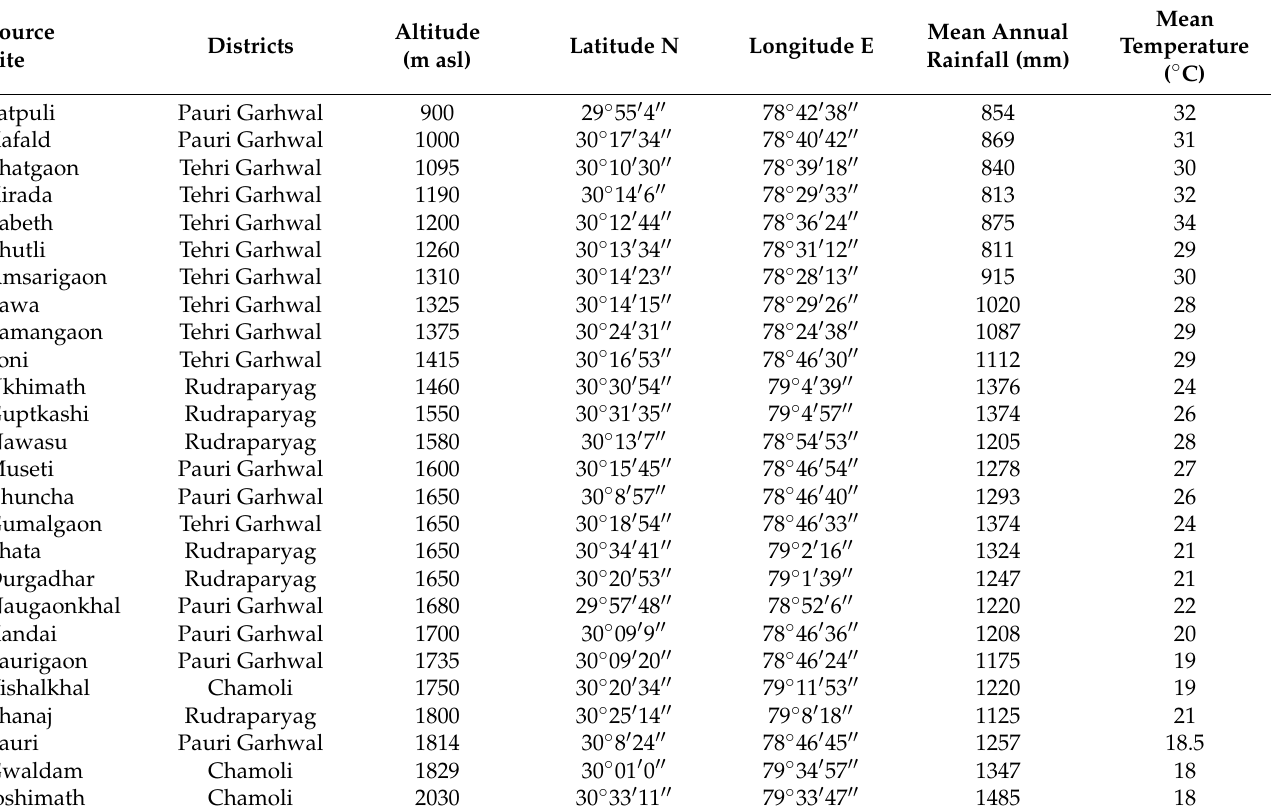
Table 1. Geographical location of C. sinensis fruit (collection sites) in the Garhwal